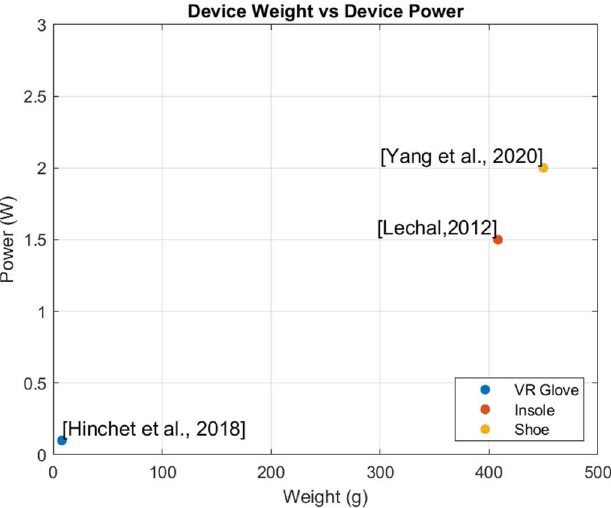
Figure 3. A scatter plot showing the weight of the haptic system against the power consumption [57,59,64].